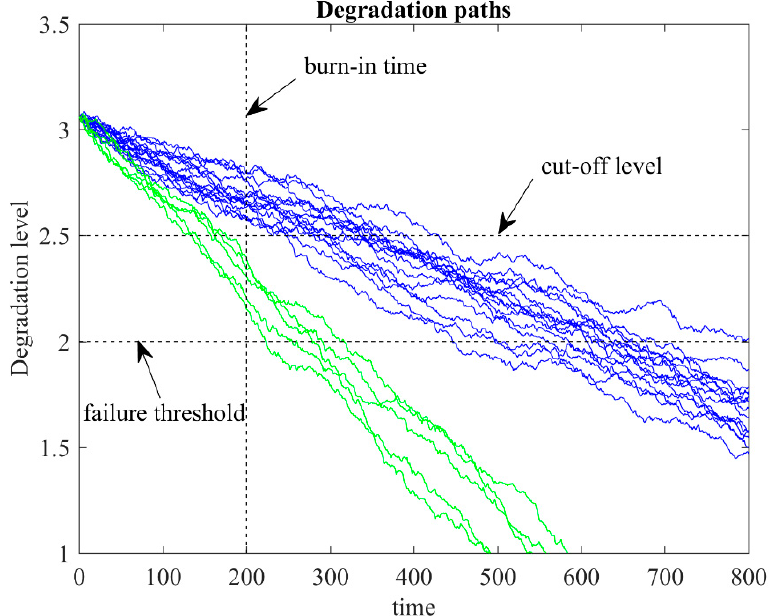
Figure 1. A demonstration of a degradation-based burn-in test.